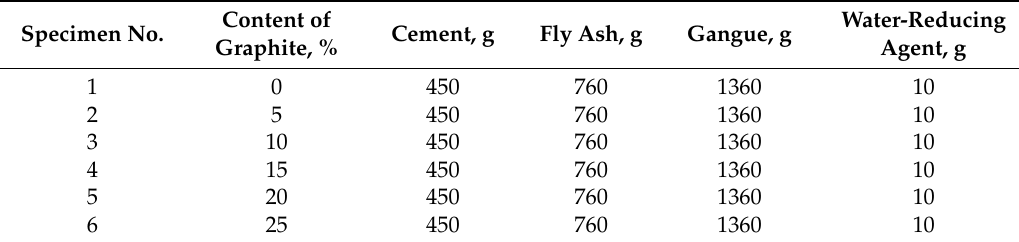
Table 2. Weights of various ingredients in the prepared specimens (in